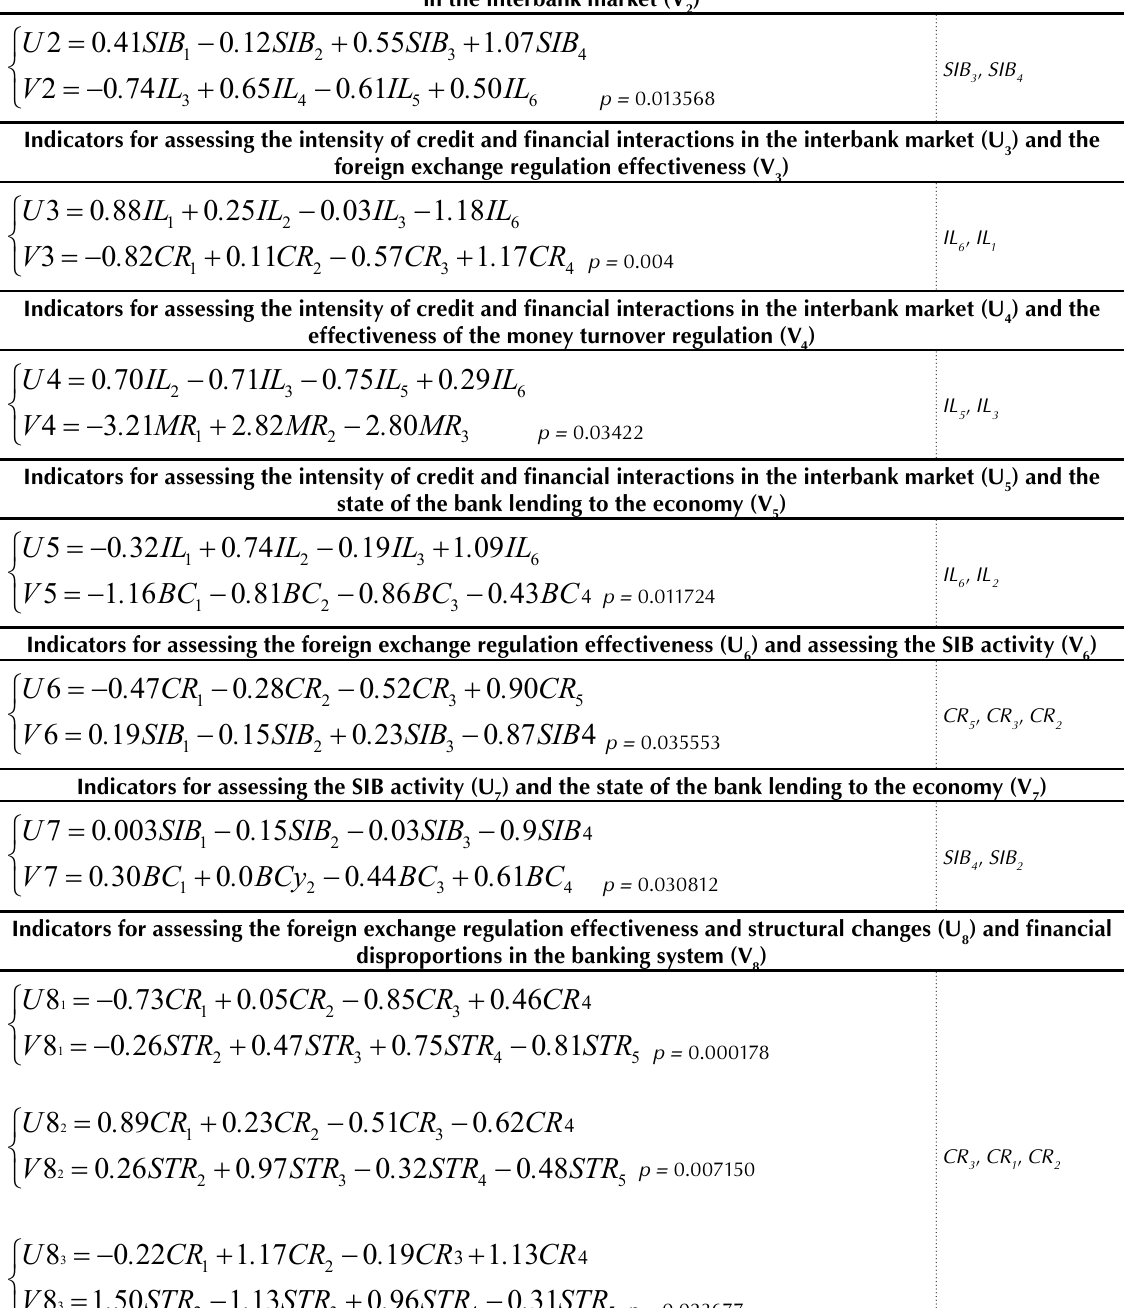
Most significant explanatory indicators ) and the 1 ) 1